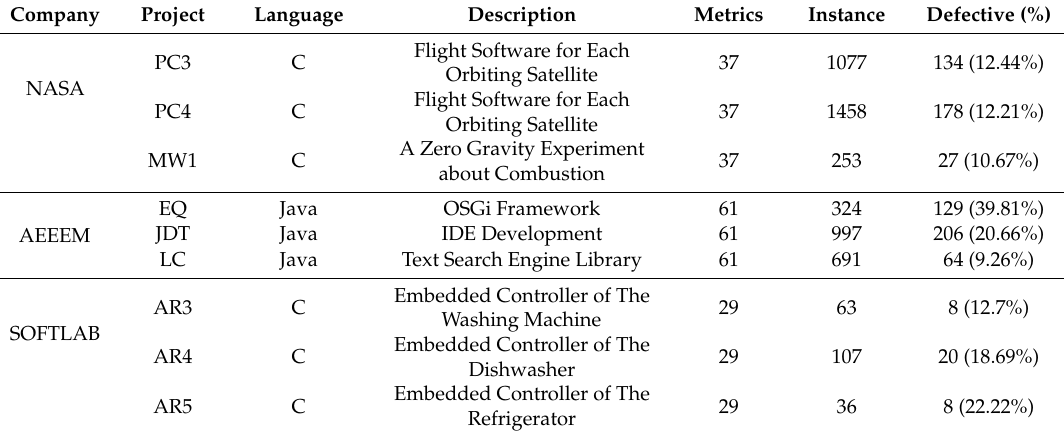
Table 2. Details of projects used in the comparison experiments.